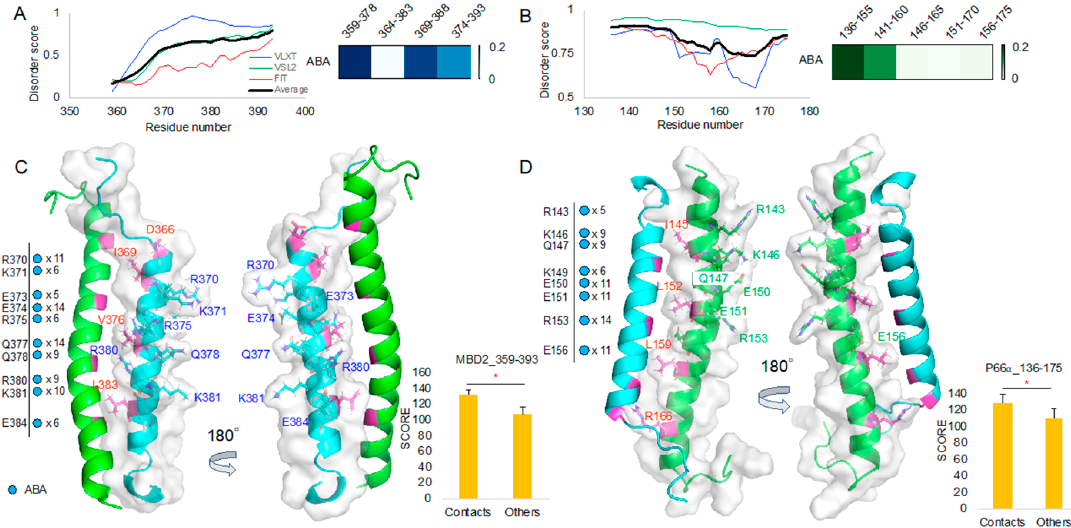
Figure 6. ABA molecular docking toward MBD2 and p66 α : ( A , B ) Protein intrinsic disorder score plot and the 10 best target region segment peptides ABA docking result T score heatmap of MBD2 (A) and p66 α (B). ( C ) MBD2 (cyan) contact residues shown on the MBD2–p66 α complex (PDB ID 2L2L) [15] and the corresponding new docking evaluation score ( y -axis) T-test between contact cases and others. ( D ) p66 α (green) contact residues shown on the MBD2–p66 α complex (PDB ID 2L2L) [15] and the corresponding new docking evaluation score (y-axis) T -test between contact cases and others. * p -value < 0.001.